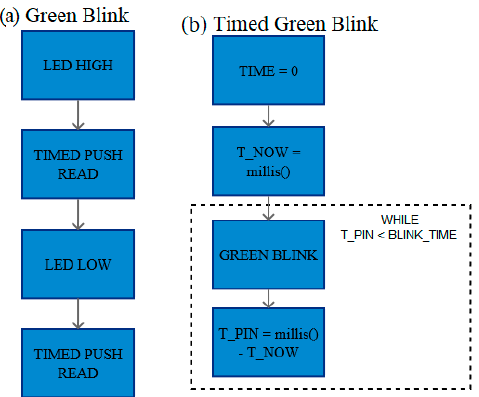
Figure 11. Block diagram of: ( a ) green blink and ( b ) timed green blink blocks.